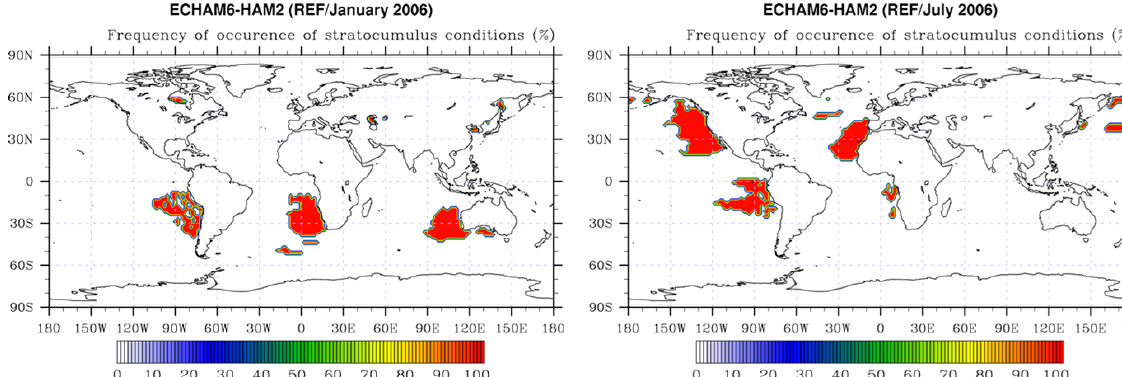
Figure A1. The stratocumulus regime in January and July